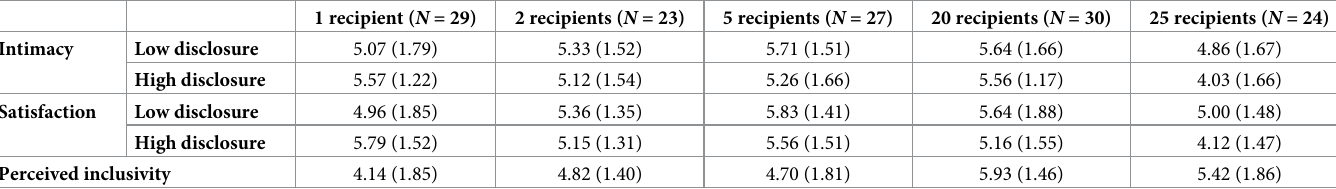
Table 4. Study 4 means and standard deviations of intimacy, satisfaction, and perceived inclusivity of messages according to number of recipients. 1 recipient ( N =